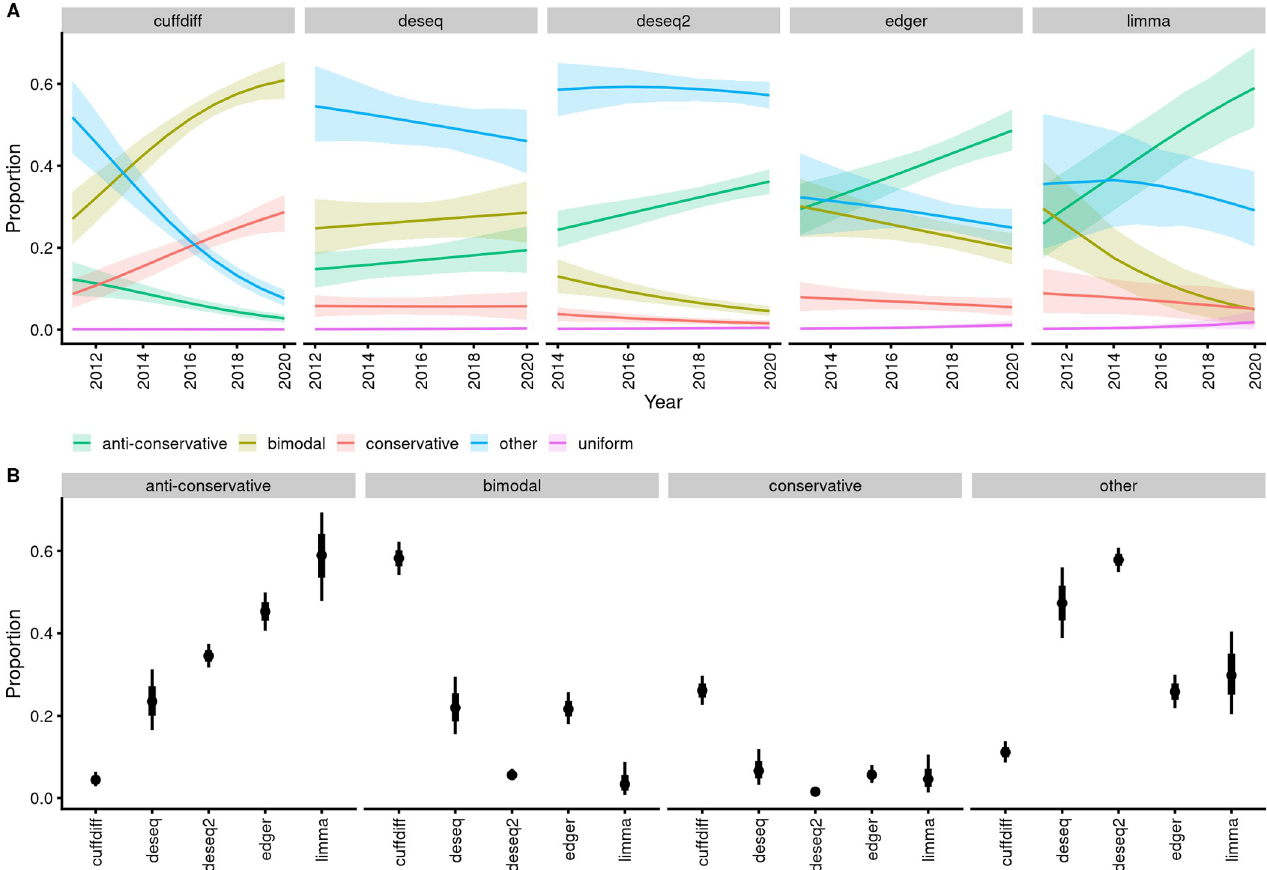
Fig 2. Association of the p -value histogram class with a differential expression analysis tool. ( A ) Time courses for proportions of different p -value histogram classes for the 5 most frequently used DE analysis platforms. Lines denote best fit of the model [class ~ year + (year | de_tool), categorical likelihood]. Shaded areas denote 95% credible regions. N = 4,616. The data file is in S1 Data ( B ) Association of p -value histogram type with DE analysis tool; data is restricted to 2018–2020 GEO submissions. Points denote best fit of the model [n | trials(total in de_tool) ~ class + de_tool + class:de_tool, binomial likelihood]. Thick and thin lines denote 66% and 95% credible intervals, respectively. N = 2,930. The model object related to panel A can be downloaded from https://gin.g- node.org/tpall/geo-htseq-paper/src/v0.1/models/Class_year__year_detool_year.rds. The model object related to panel B can be downloaded from